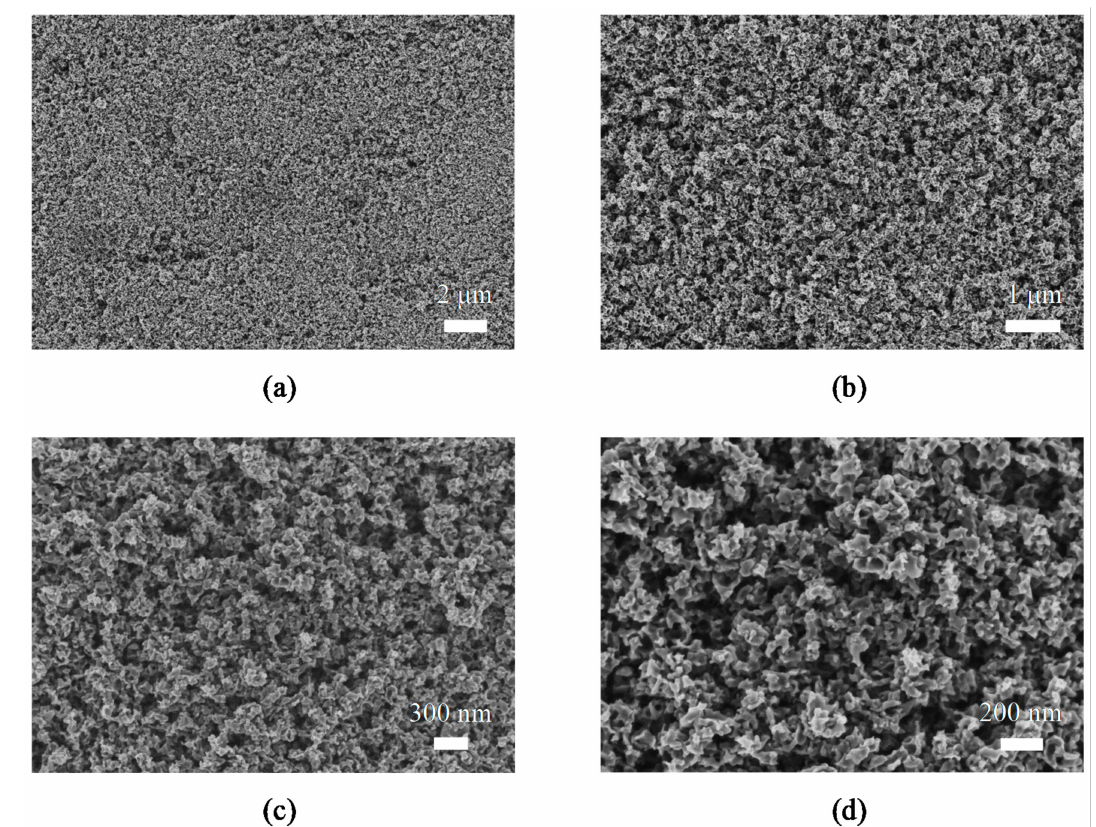
Figure 7. High resolution FE-SEM images of the TiO 2 /ZnO hybrid nanosponges electrodeposited on crystalline TiO 2 for 15 min at 75 ◦ C with 10 mM Zn(NO 3 ) 2 at ( a ) 5000 × , ( b ) 15,000 × , ( c ) 30,000 × , and ( d ) 50,000 ×